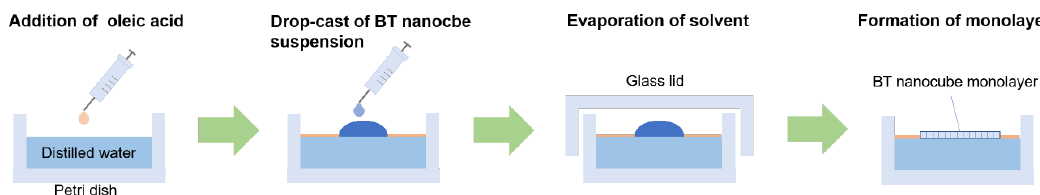
Figure 1. Schematic illustration of our self-assembly process. First, oleic acid diluted with toluene is added to a water surface in a petri dish. After toluene evaporation, the barium titanate (BT) nanocube suspension (mesitylene solvent) is dropped onto the oleic acid-added water surface. The petri dish is covered by a glass lid during mesitylene evaporation under room temperature. As a result of mesitylene evaporation, BT nanocube monolayers form at the air-water interface.